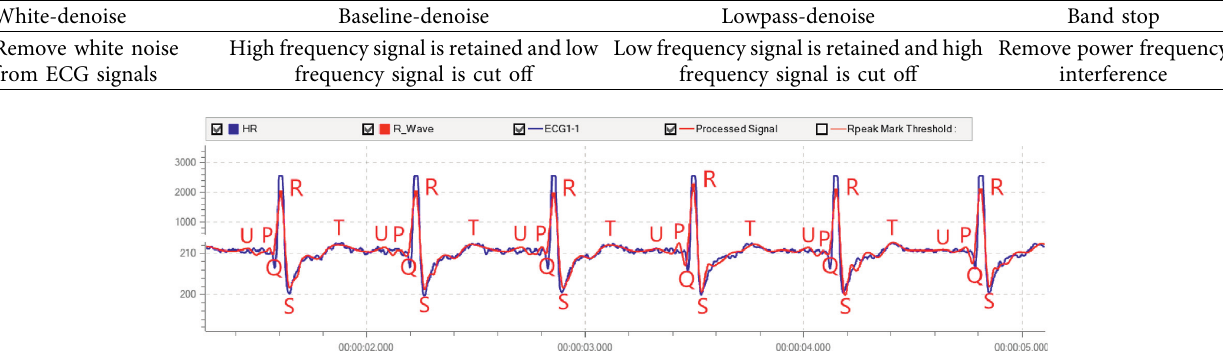
Figure 10: Comparison of ECG signal before and after